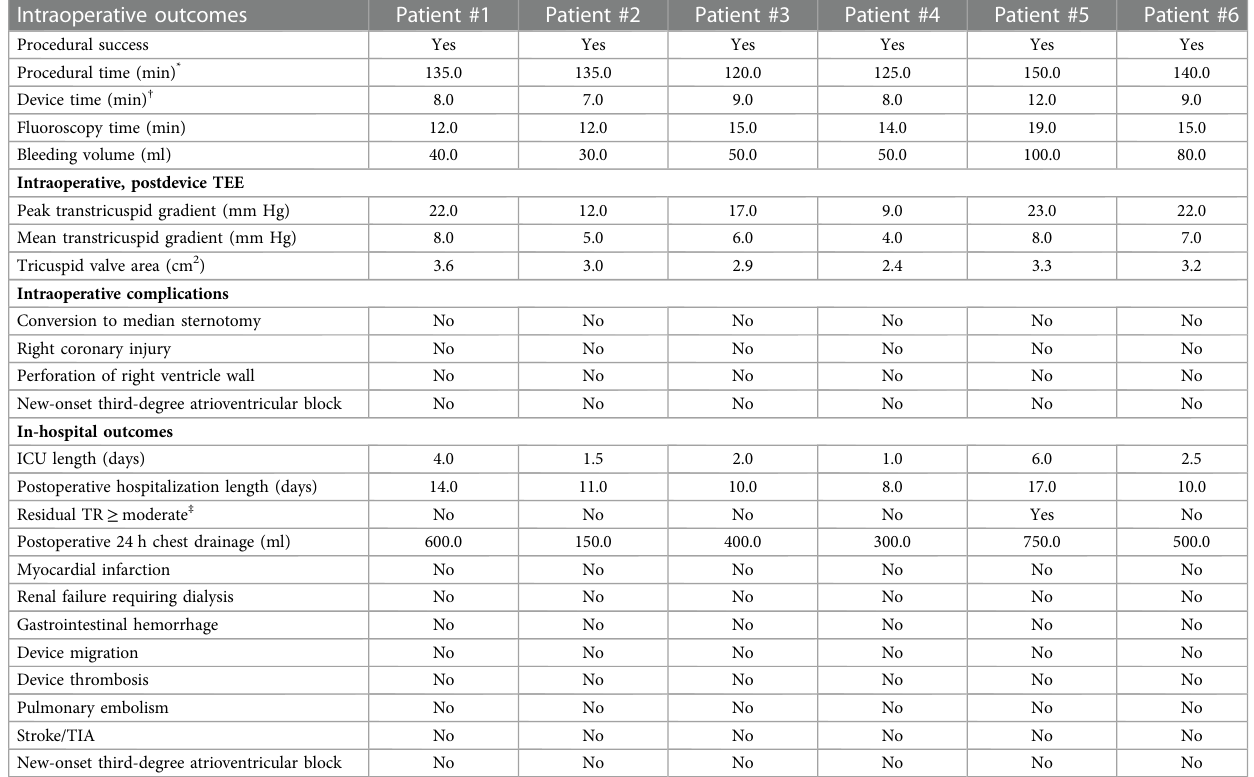
TABLE 4 Intraoperative and in-hospital outcomes.